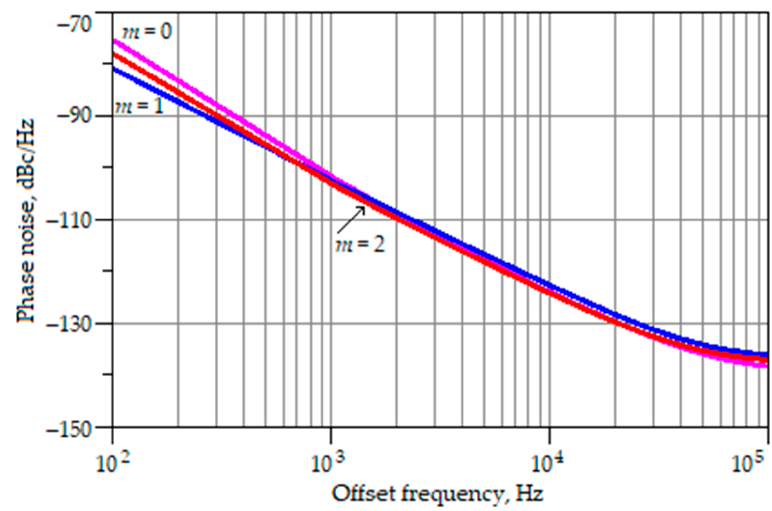
Figure 28. Phase noise versus offset frequency for VCO with multiple-output improved Wilson current mirror when V d = 12 V, R L = 50 Ω ; m = 0—purple curve ( C a = 9 pF), m = 1—blue curve ( C a = 12 pF), m = 2—red curve ( C a = 13 pF).